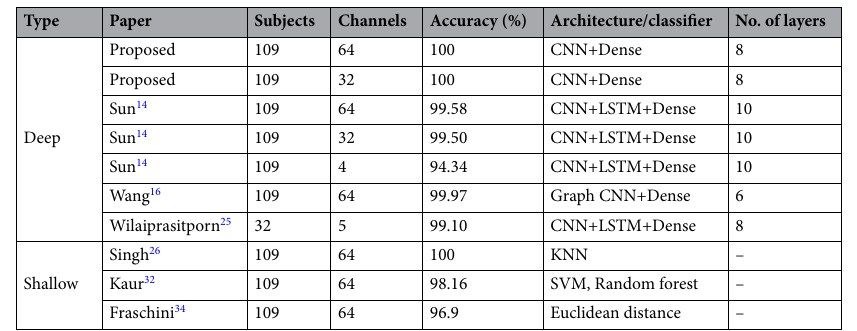
Table 2. Comparison with some state-of-the-art EEG based identification